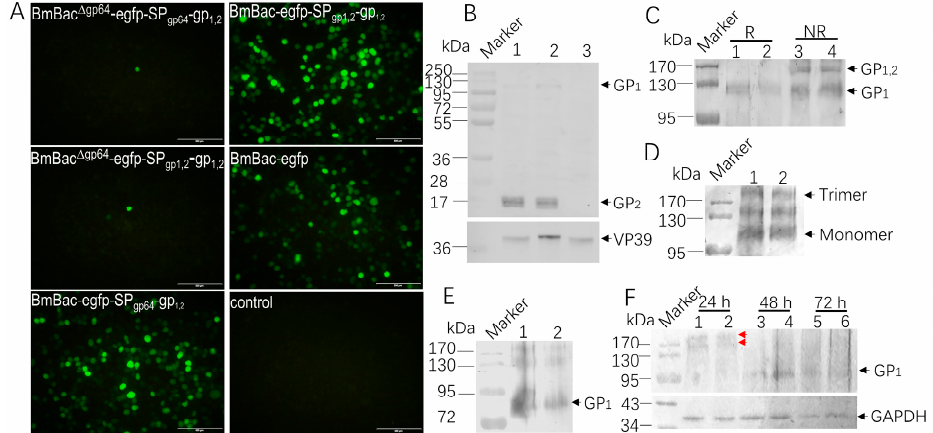
Figure 2. Expression of glycoprotein (GP) in BmN cells. ( A ) Fluorescence of transfection with different constructs in BmN cells. Fluorescence was recorded at 120 h p.t.; bar, 500 µm. ( B ) GP 1,2 expression in infected BmN cells. BmN cells were infected with BmBac-egfp-SP gp64 -gp 1,2 (lane 1) and BmBac-egfp-SP gp1,2 -gp 1,2 (lane 2) or BmBac-egfp (lane 3) and harvested at 48 h p.i.; the cells were lysed and subjected to SDS-PAGE and western blot analysis with a monoclonal antibody against GP and BmNPV VP39. ( C ) Mobility of the GP 1,2 protein in the SDS-PAGE gel presence or absence of the reducing reagent dithiothreitol (DTT). BmN cells were infected with BmBac-egfp-SP gp64 -gp 1,2 (lane 1, lane 3) and BmBac- egfp-SP gp1,2 -gp 1,2 (lane 2, lane 4) and harvested at 48 h p.i., then cell lysis were mixed with DTT (R) or without DTT (NR) protein sample buffers, heated at 95 °C for 5 min, and then subjected to SDS-PAGE followed by western blot analysis using a polyclonal antibody against the Ebola GP protein. ( D ) Analysis of trimerization of GP in BmN cell (48 h p.i.). Western blot analyses of GP proteins separated by native gel followed by western blot analysis using a polyclonal antibody against the Ebola GP protein. Lane 1, BmBac-egfp-SP gp1,2 -gp 1,2 , lane 2, BmBac-egfp-SP gp1,2 -gp 1,2 . ( E ) Deglycosylation assay on GP in BmN cells. 5 µL lysed cells samples (48 h p.i.) were mixed with 1 µL PNGase F and incubated for 4 h at 37 °C, then the samples were subjected to SDS-PAGE gel and western blot using a polyclonal antibody against the Ebola GP protein. Lane 1, BmBac-egfp-SP gp1,2 -gp 1,2 , lane 2, BmBac-egfp-SP gp1,2 - gp 1,2 . ( F ) Expression profiles of GP in BmN cells. BmN cells were infected with BmBac-egfp-SP gp1,2 -gp 1,2 (lane 1, lane 3, and lane 5) and BmBac-egfp-SP gp1,2 -gp 1,2 (lane 2, lane 4, and lane 6), and harvested at indicated time point, samples were mixed with protein sample buffers with DTT and heated at 95 °C for 5 min, and then subjected to SDS-PAGE followed by western blot analysis using a polyclonal antibody against the Ebola GP protein. 3.3. The GP64 Signal Peptide Results in Ebola GP Localization to the Plasma Membrane of BmN Cells Localization of EBOV-GP in infected BmN cells was monitored by confocal microscopy. To this end, cells were grown in confocal dishes and infected with BmBac-egfp-SP gp64 -gp 1,2 , BmBac-egfp- SP gp1,2 -gp 1,2 , and BmBac-egfp (Figure 3A–G) and fixed, and the anti-GP antibody was applied for GP localization at 48 h p.i. Images were captured at 405 nm for Hoechst-stained DNA, 488 nm for eGFP, and 555 nm for the secondary antibody. As shown in Figure 3, green fluorescence was observed in cells infected with both viruses (Figure 3, eGFP panel), which indicates that the cells were infected efficiently. The GP protein with the GP64 signal peptide was mainly localized to the plasma membrane (Figure 3A–C, red fluorescence), and there was a filipodial shape located around the cell (Figure 3B–C). Conversely, full-length GP was uniformly distributed in the cytoplasm, no red fluorescence was observed at the plasma membrane, furthermore, GP was accumulated in cytoplasm and some red fluorescent dots were found clearly around the nucleus (Figure 3D–F). In addition,